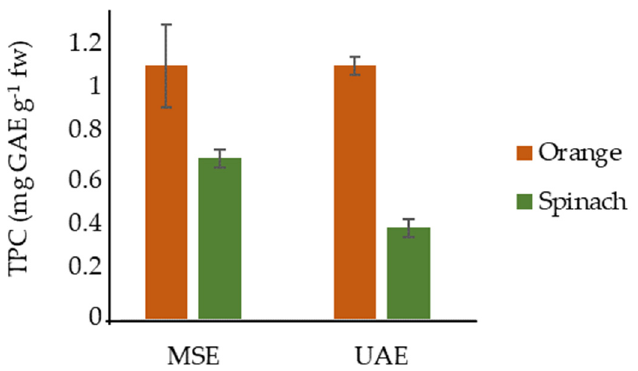
Figure 1. Comparison of TPC yield of MSE and UAE under selected conditions from agri-food res- idues.